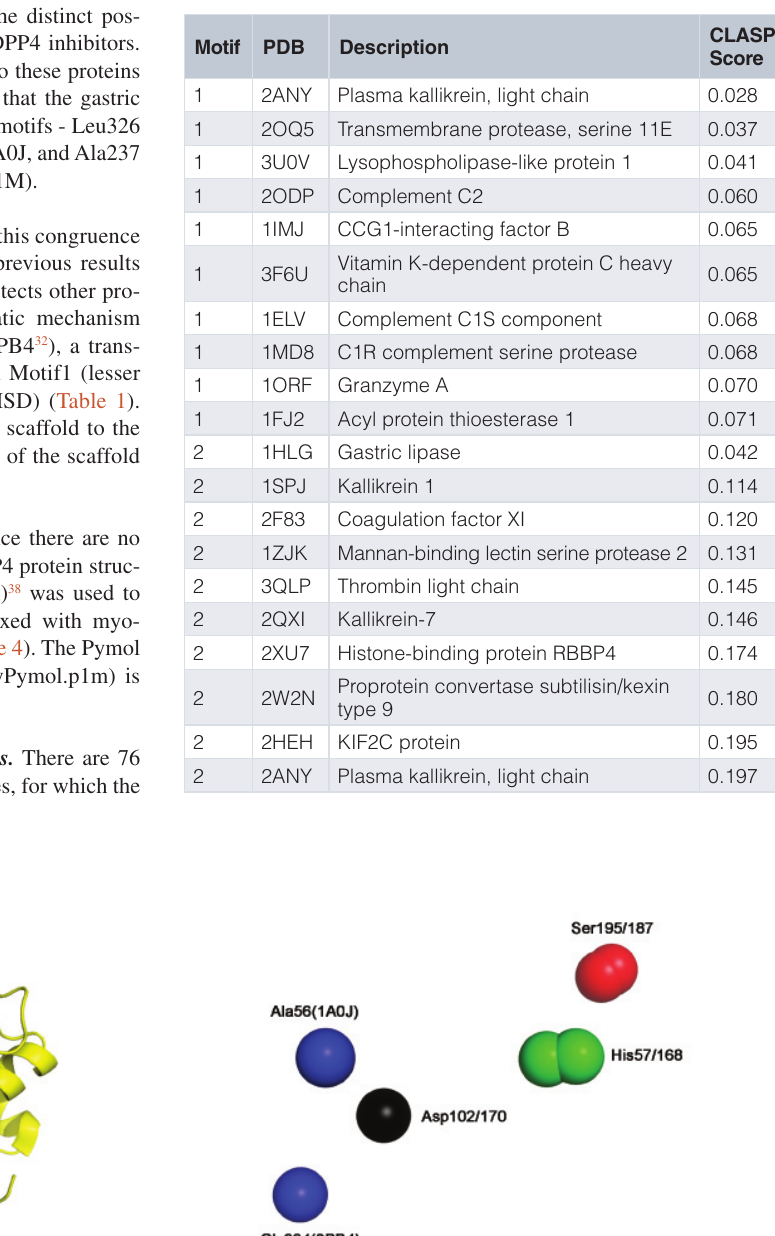
Table 2. Best matches in the set of ~5000 human proteins. (a) Motif1 (Asp102, Ser195, His57, Ala56) from Trypsin (b) Motif2